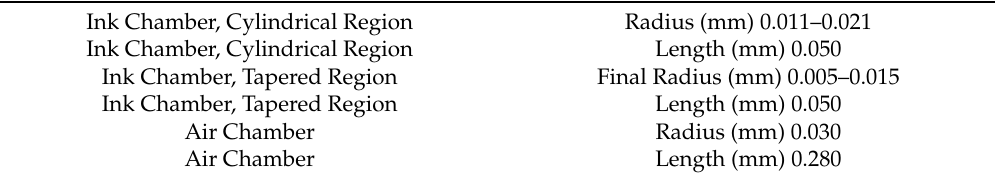
Table 1. Geometry Table 1. Geometry dimensions.